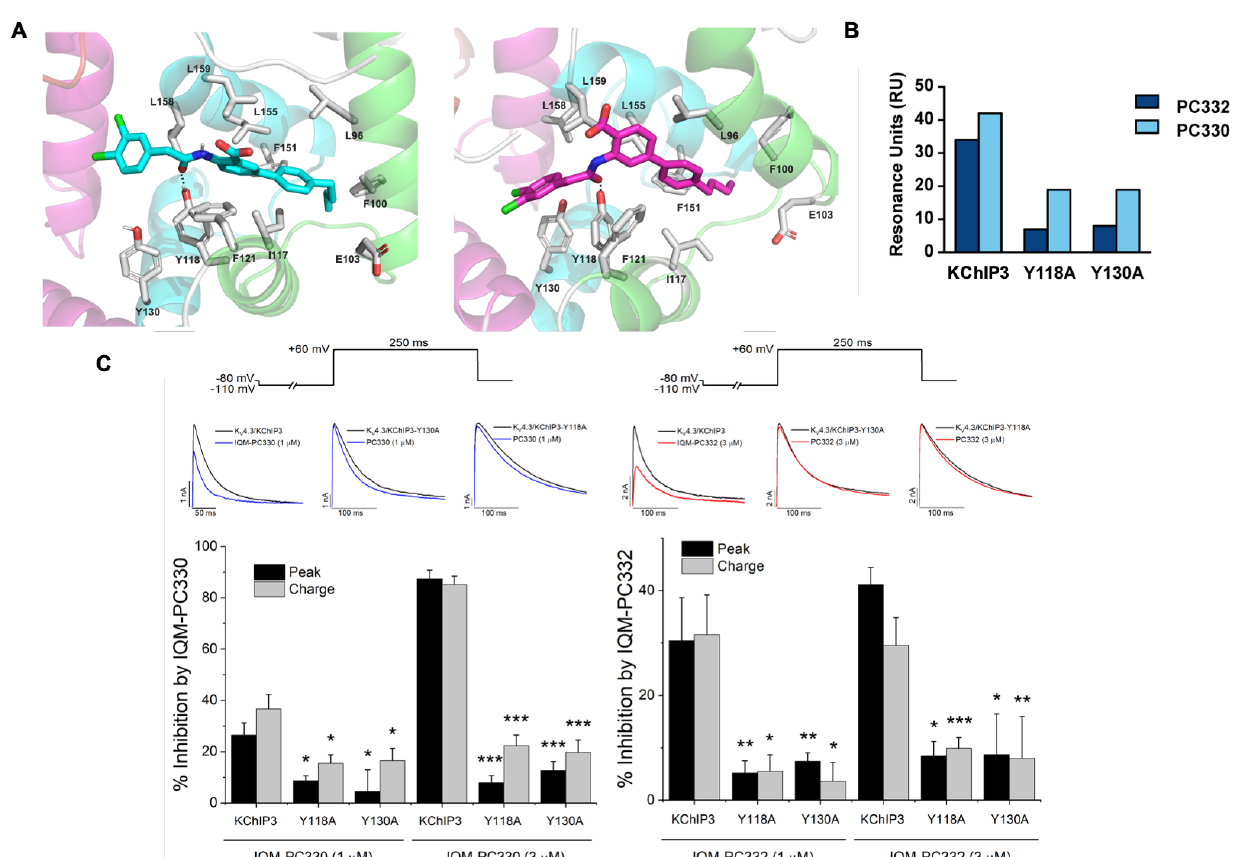
Figure 7. Binding site of IQM-PC330 and IQM-PC332 [69]. ( A ) Cartoon representation of the molecular docking complex of KChIP3 bound to IQM-PC330 (right) and IQM-PC332 (left). ( B ) Direct binding of IQM-PC330 and IQM-PC332 in surface plasmon resonance (SPR) assays to immobilized wtKChIP3 compared with Tyr118Ala and Tyr130Ala KChIP3 mutants. ( C ) Electrophysiological effects of IQM-PC330 and IQM-PC332 on K V 4.3/KChIP3 wt and K V 4.3/KChIP3 mutant channels. Data are shown as mean ± SEM. * p < 0.05 vs. block produced in K V 4.3/DREAM wt channels; ** p < 0.01 vs. block produced in K V 4.3/DREAM wt channels; *** p < 0.001 vs. block produced in K V 4.3/DREAM wt